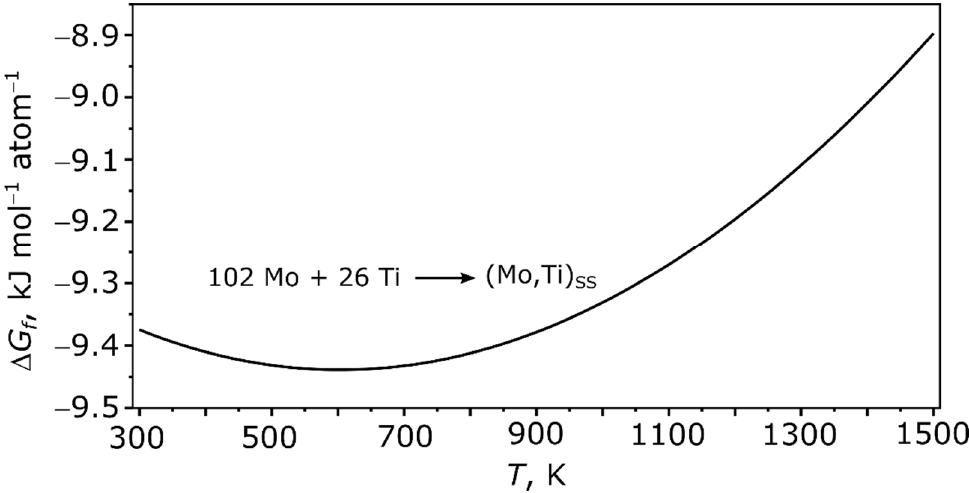
Figure 6. Enthalpy of formation of the (Mo,Ti) SS .